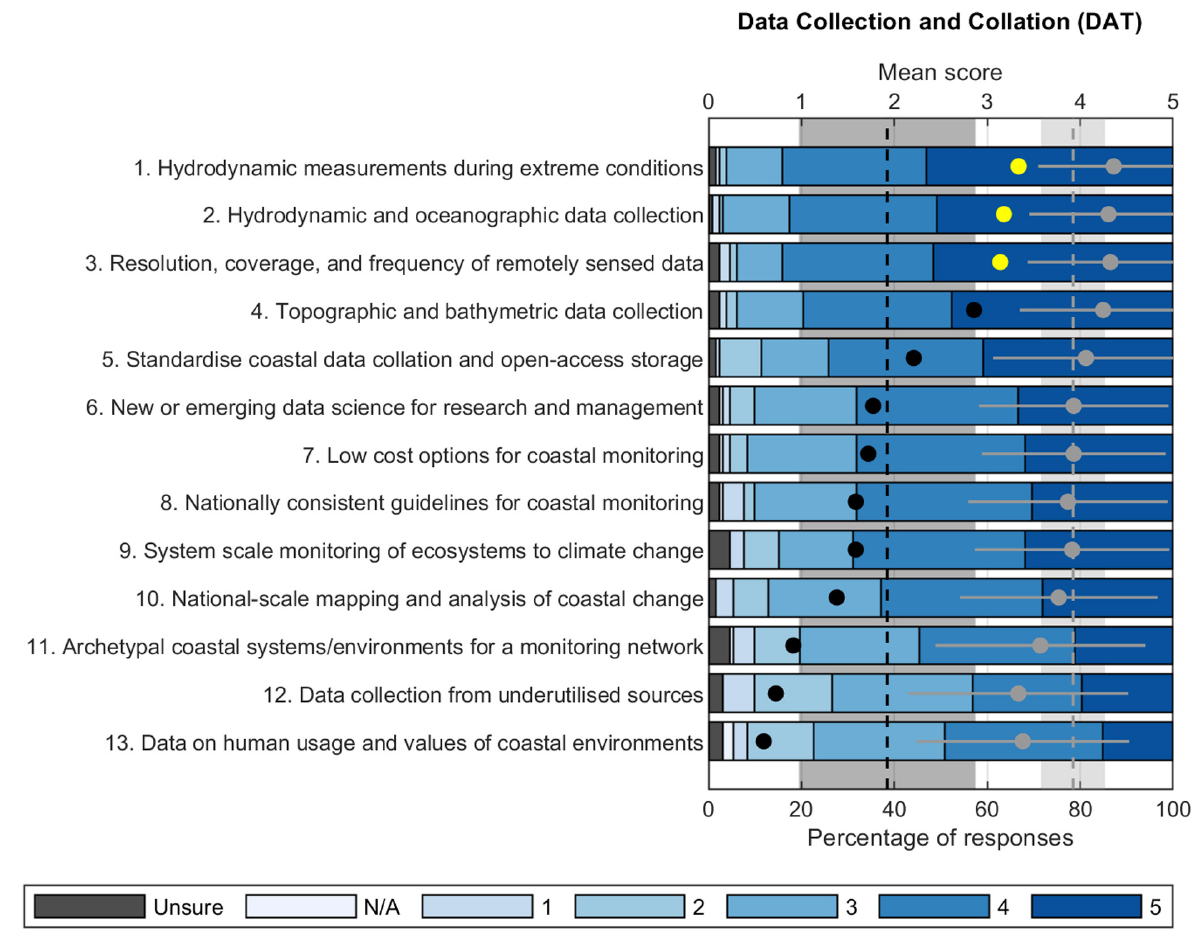
FIGURE 5 | Stacked bar plot showing the distribution of Stage 3 respondent scores for priorities in the Data Collection and Collation (DAT) category. The percentage of respondent scores (see legend) for each priority is shown by the horizontal stacked bars (bottom x -axis). Numbers prefacing the shortened priorities represent priority ranks based on weighted mean scores. Grey circles and horizontal lines represent mean scores ( ¯ R ) and one standard deviation either side of the mean (see top x -axis). The light grey shaded box and vertical light grey dashed line represent the mean of the mean scores and one standard deviation either side of that mean. Black and yellow circles represent the weighted scores ( ¯ R w , see top x -axis). The dark grey shaded box and vertical black dashed line represent the mean of the weighted scores and one standard deviation either side of that mean. Yellow circles indicate weighted scores that were greater than one standard deviation above the mean of the weighted